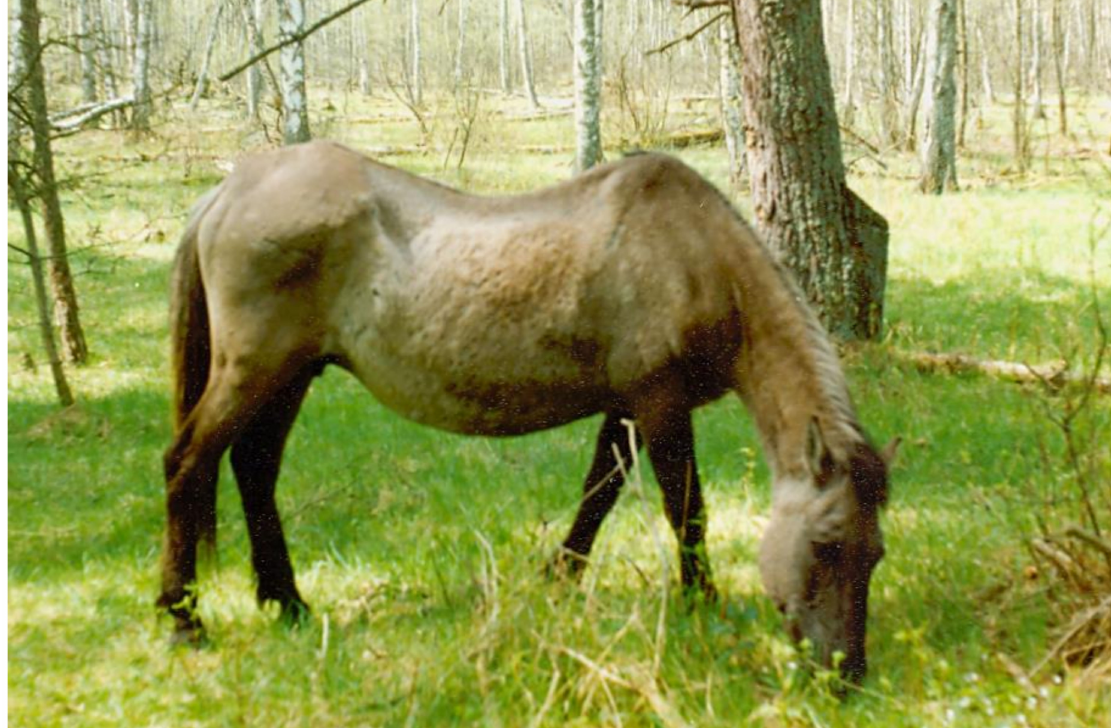
Figure 2. The oldest mare in Popielno sanctuary as a 29-year-old (photo by Zbigniew